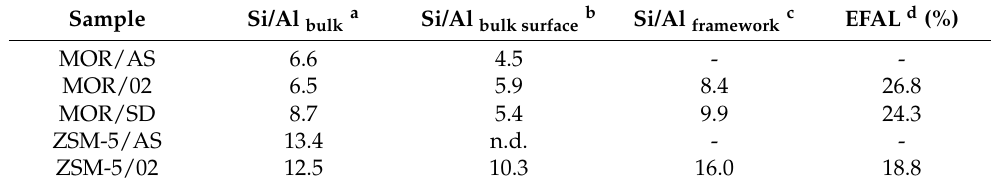
Table 1. Bulk, bulk surface, framework Si/Al molar ratio, and EFAL content of the studied zeolites.